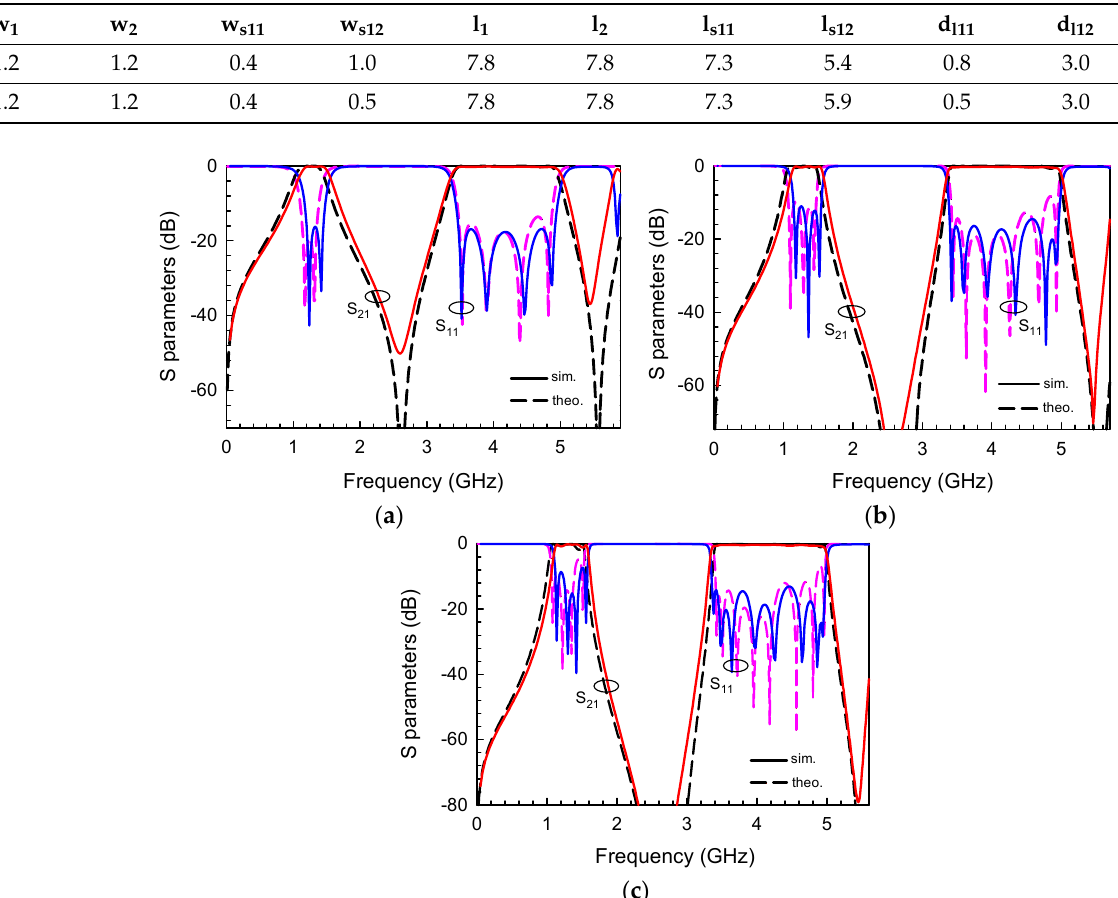
Figure 11. Comparison of the simulated and calculated frequency response for ( a ) N = 2, ( b ) N = 3, ( c ) N = 4. Table 1. Dimensions (in mm) of the two-band filters having first/second passband with 2nd/4th order.